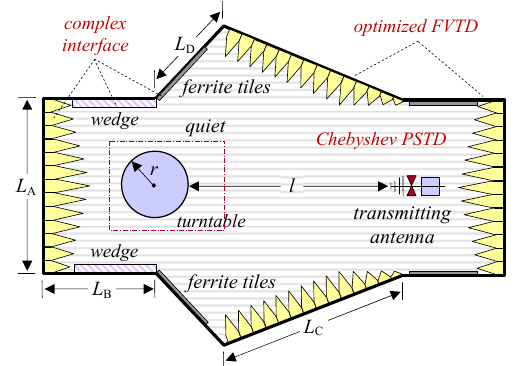
Figure 20: A double-horn semi-anechoic chamber. Modeling regions: complex-interface schemes for the absorbers, opti- mized FVTD technique for the walls, and PSTD algorithm for the interior of the facility.